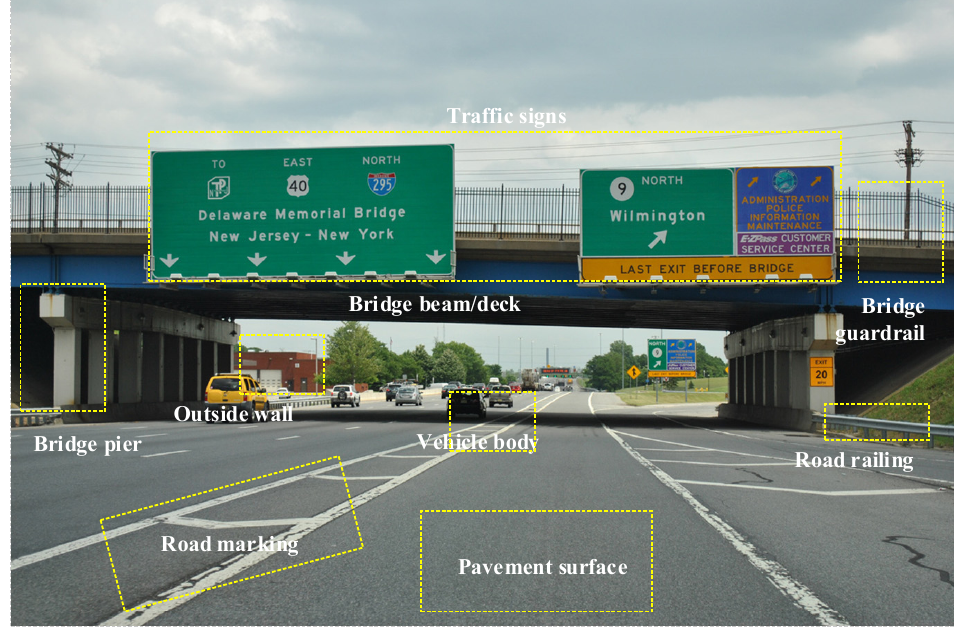
Figure 1. Possible applications of Nano-TiO 2 coating (background photo from online).